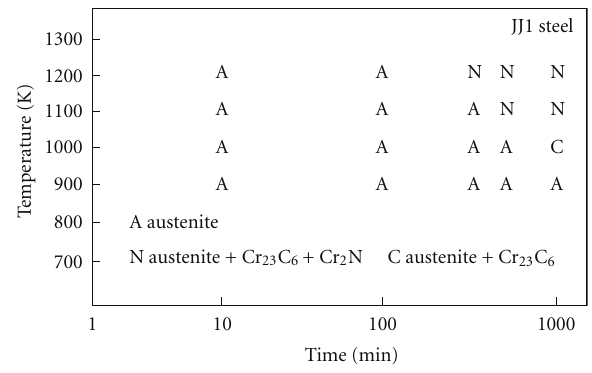
Figure 11: Time-temperature precipitation diagram of JJ1